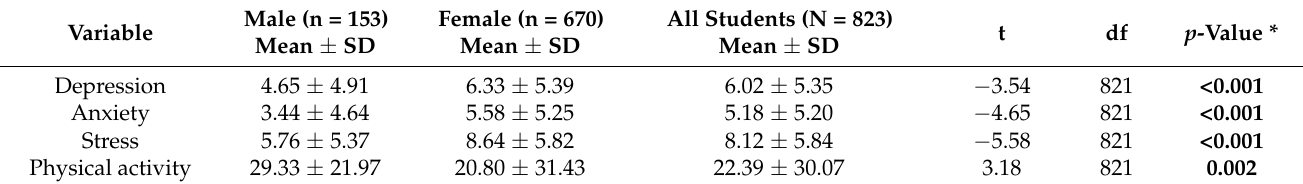
Table 6. Gender-related differences of students’ scores on the DASS-21 and the GSLTPAQ (N = 823).